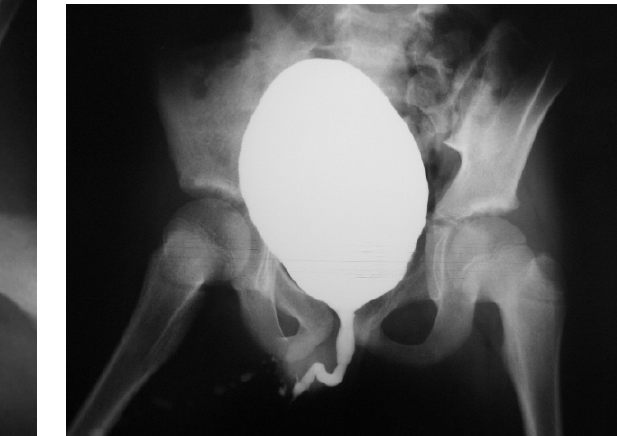
Figure 2. Follow-up voiding cystourethrogram: normal appear- ance of the urethra, no vesicoureteral reflux is